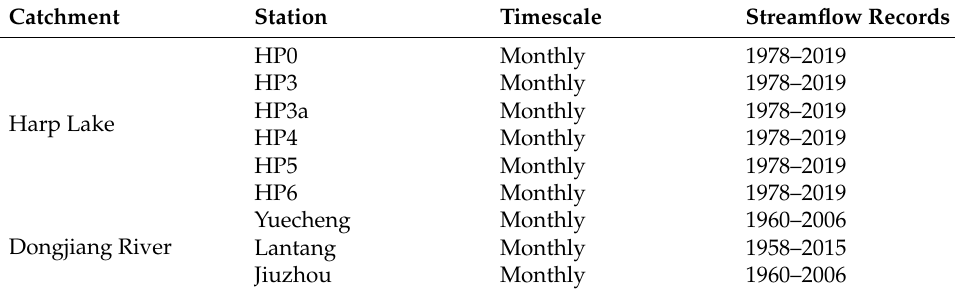
Figure 2. Location of the Harp Lake catchment ( a ) and Dongjiang River catchment ( b ), and their corresponding hydrological monitoring stations. Table 1. The data for this